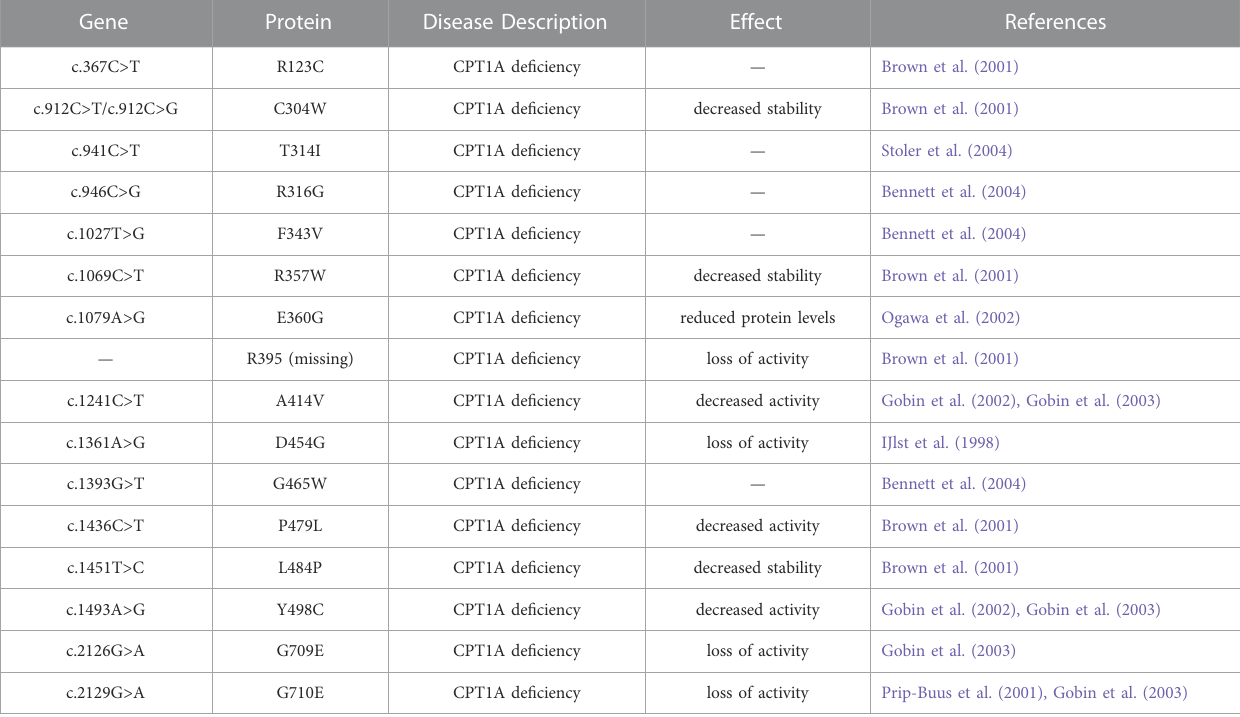
TABLE 1 Natural mutations of CPT1A found in